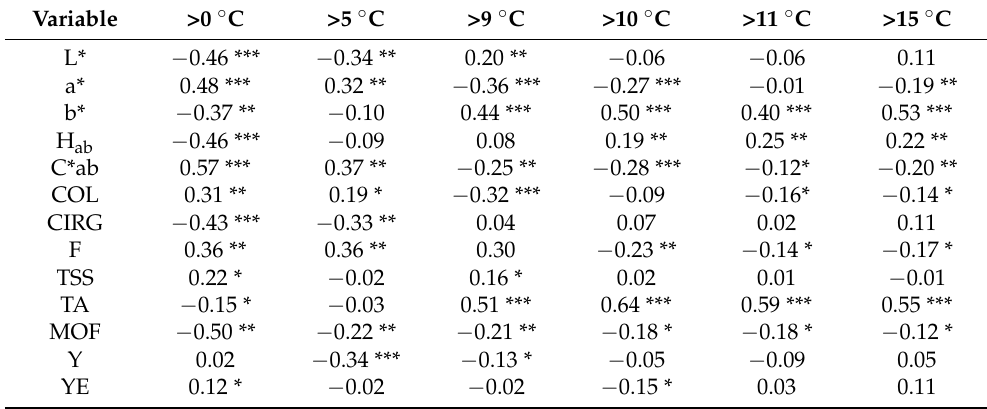
Figure 5. Influence of active temperatures on: ( A )—flowering date, ( B )—ripening date. Table 14. Influence of the total of active temperatures until the flowering date on selected